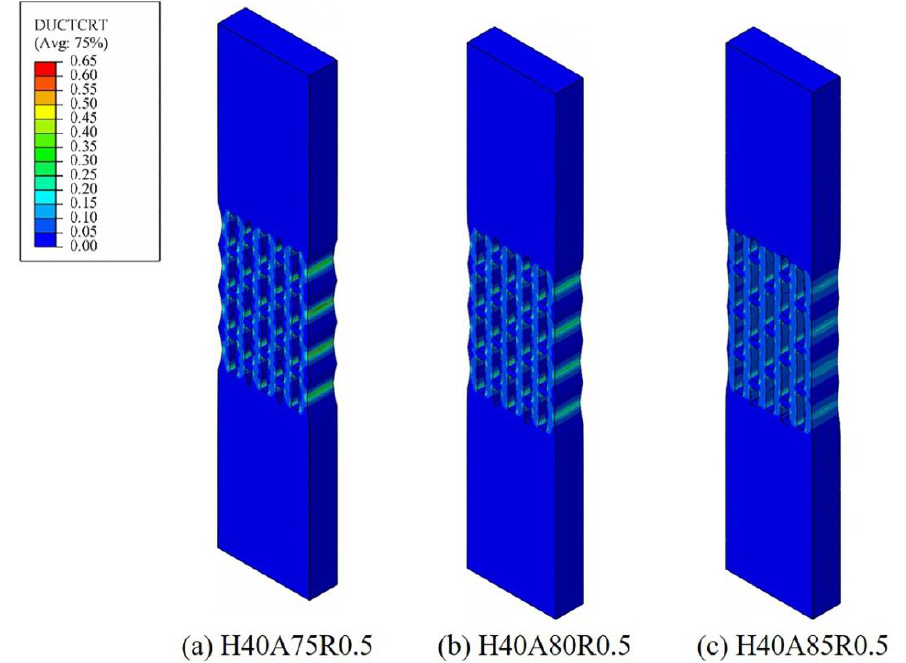
Figure 17. E ff ect of concave angle on damage index with ( a ) H40A75R0.5 ( b ) H40A80R0.5 and Figure 17. Effect of concave angle on damage index with (a) H40A75R0.5 (b) H40A80R0.5 and ( c ) (c)H40A85R0.5.